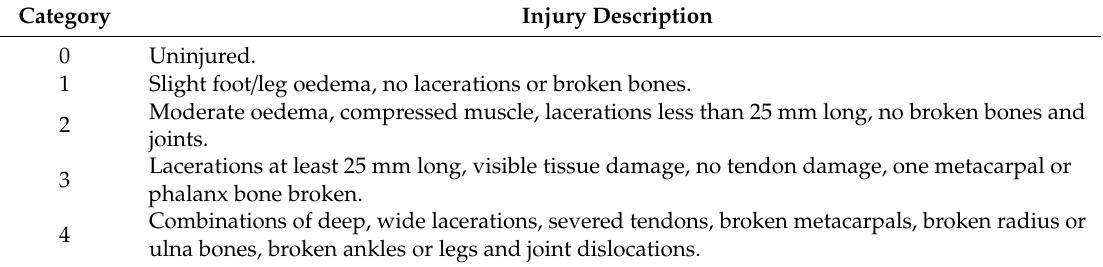
Categorisation of injury types for comparison of injuries associated with soft-catch leg-hold